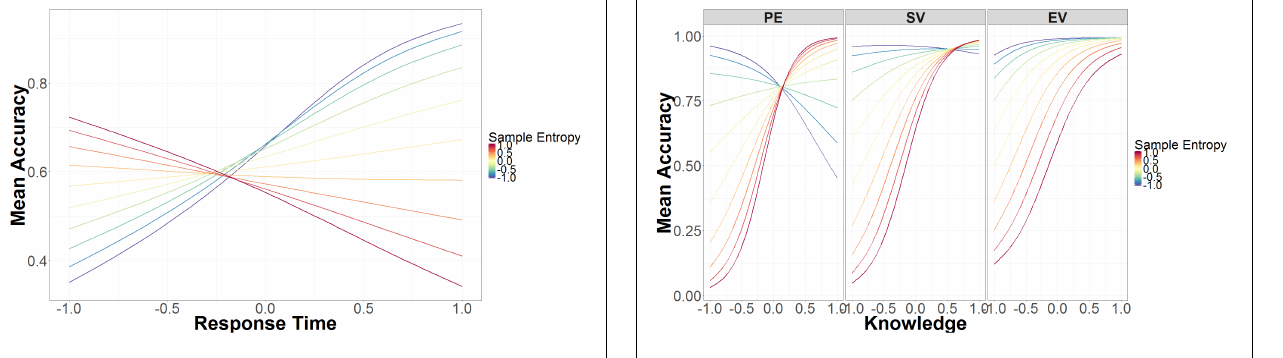
FIGURE 4 | Mean accuracy based on mouse trajectory SE and RT. The data on the x-axis are normalized and range from 2 SD below the mean ( − 1.00) to 2 SD above the mean ( + 1.00).